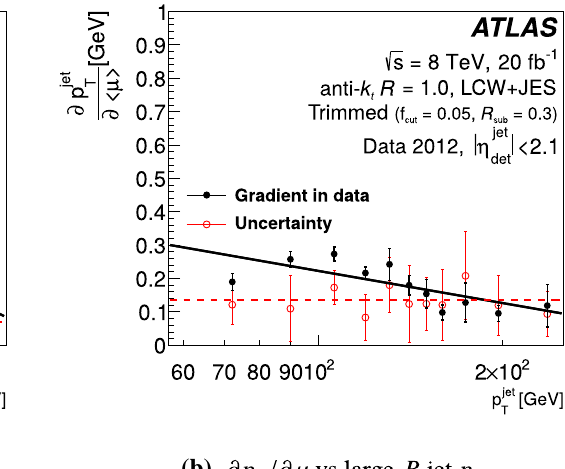
tainty (red dashed line) and a function of the form a + b log ( p T / p T,0 )